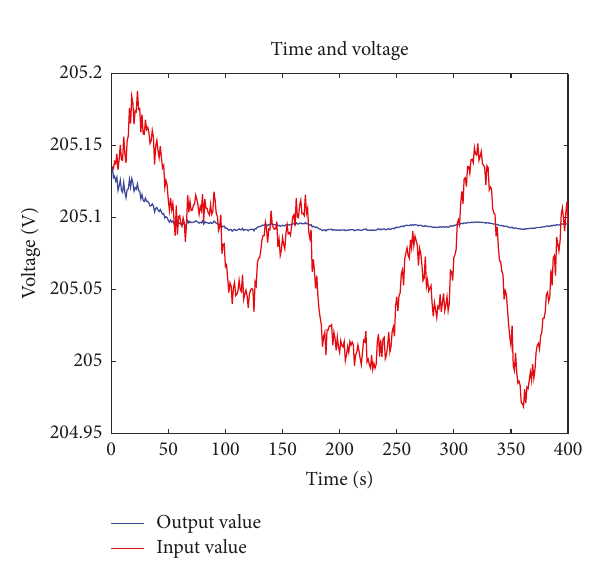
Figure 9: General controller.